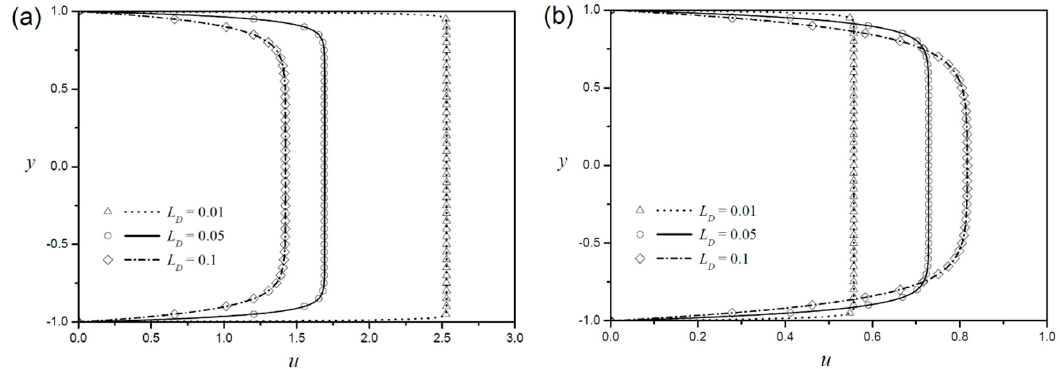
Figure 3. Velocity profiles with symmetric zeta potentials according to different Debye lengths for ( a ) shear-thinning fluid ( n = 0.8) and ( b ) shear-thickening fluid ( n = 1.2